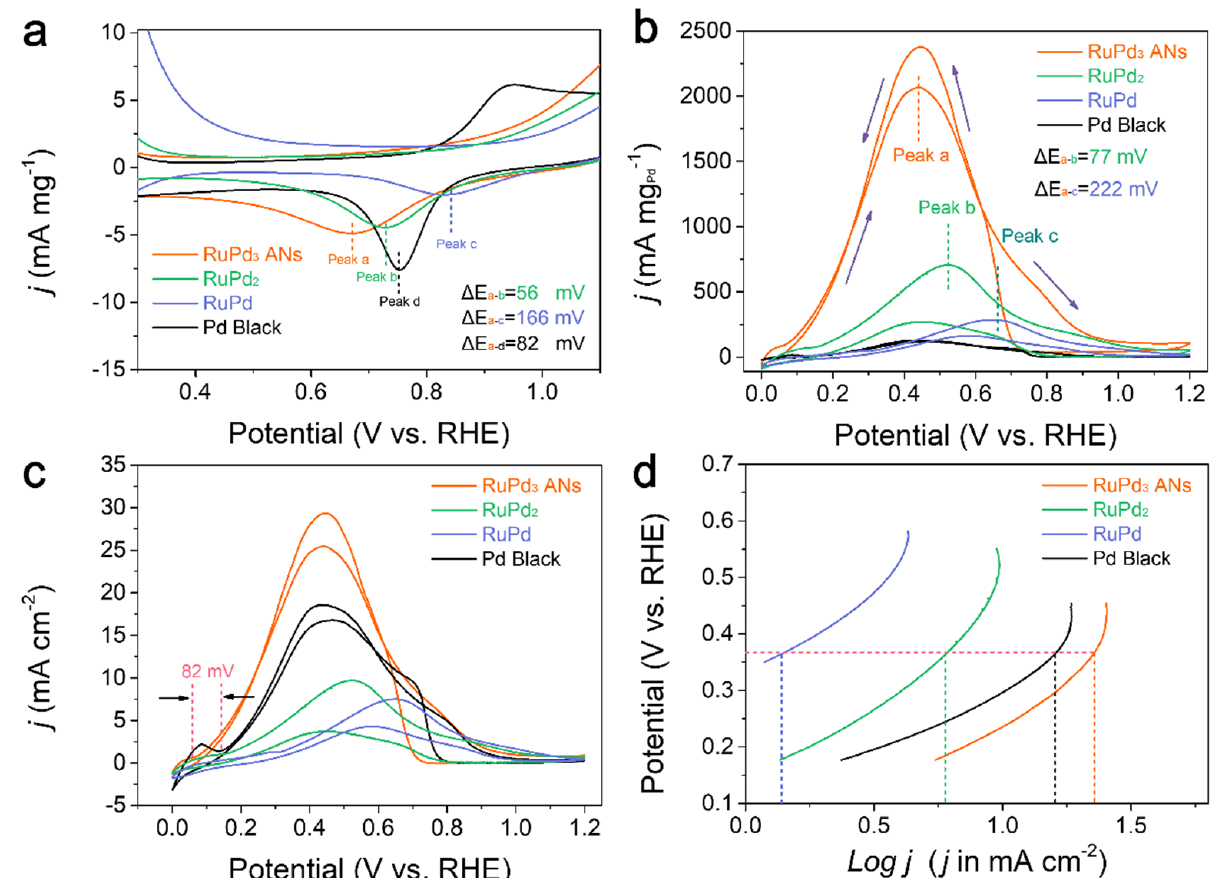
Figure 4. Comparison of the formic acid oxidation reaction (FAOR) performances of RuPd 3 ANs, RuPd 2 , RuPd and Pd black. ( a ) Cyclic voltammetry (CV) curves (enlarged image) in 0.5 M H 2 SO 4 solution; ( b ) mass ‐ normalized and ( c ) area ‐ normalized FAOR curves in N 2 ‐ saturated 0.5 M H 2 SO 4 + 0.5 M HCOOH solution; ( d ) Tafel plots.